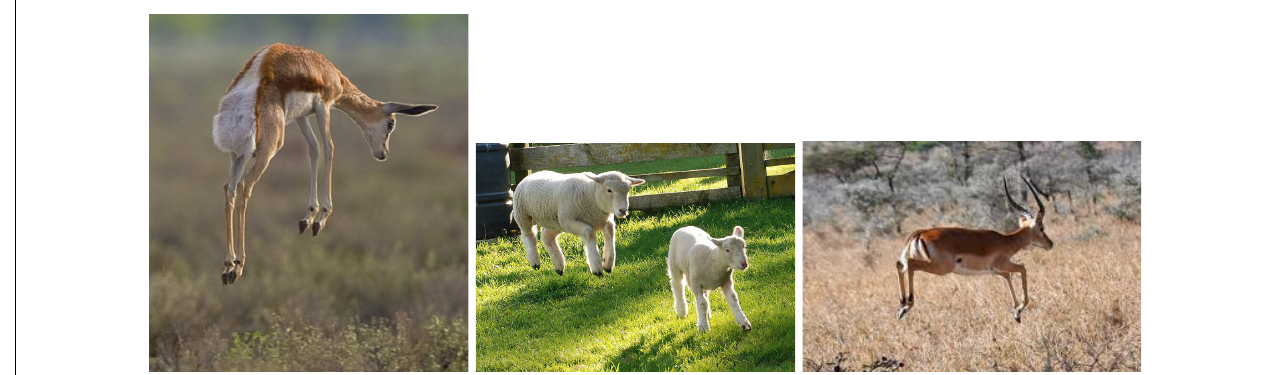
FIGURE 7 | Just for fun? Stotting behavior in animals . The animals spring into the air vertically with all feet lifting simultaneously. The evolutionary advantage seems to be unclear. Authors: Yathin Sk (left), Pam from near Matamata (middle), Rick Wilhelmsen (right), all pictures from Wikimedia commons.